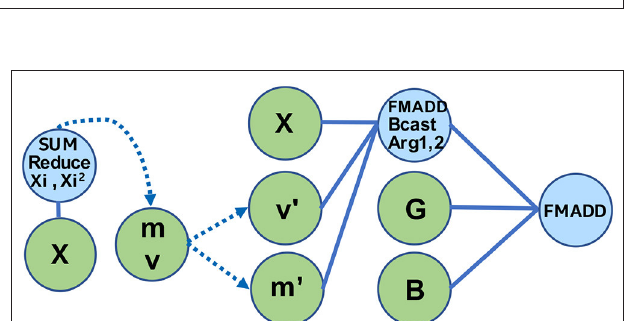
FIGURE 14 | Softmax operator by combining TPPs.